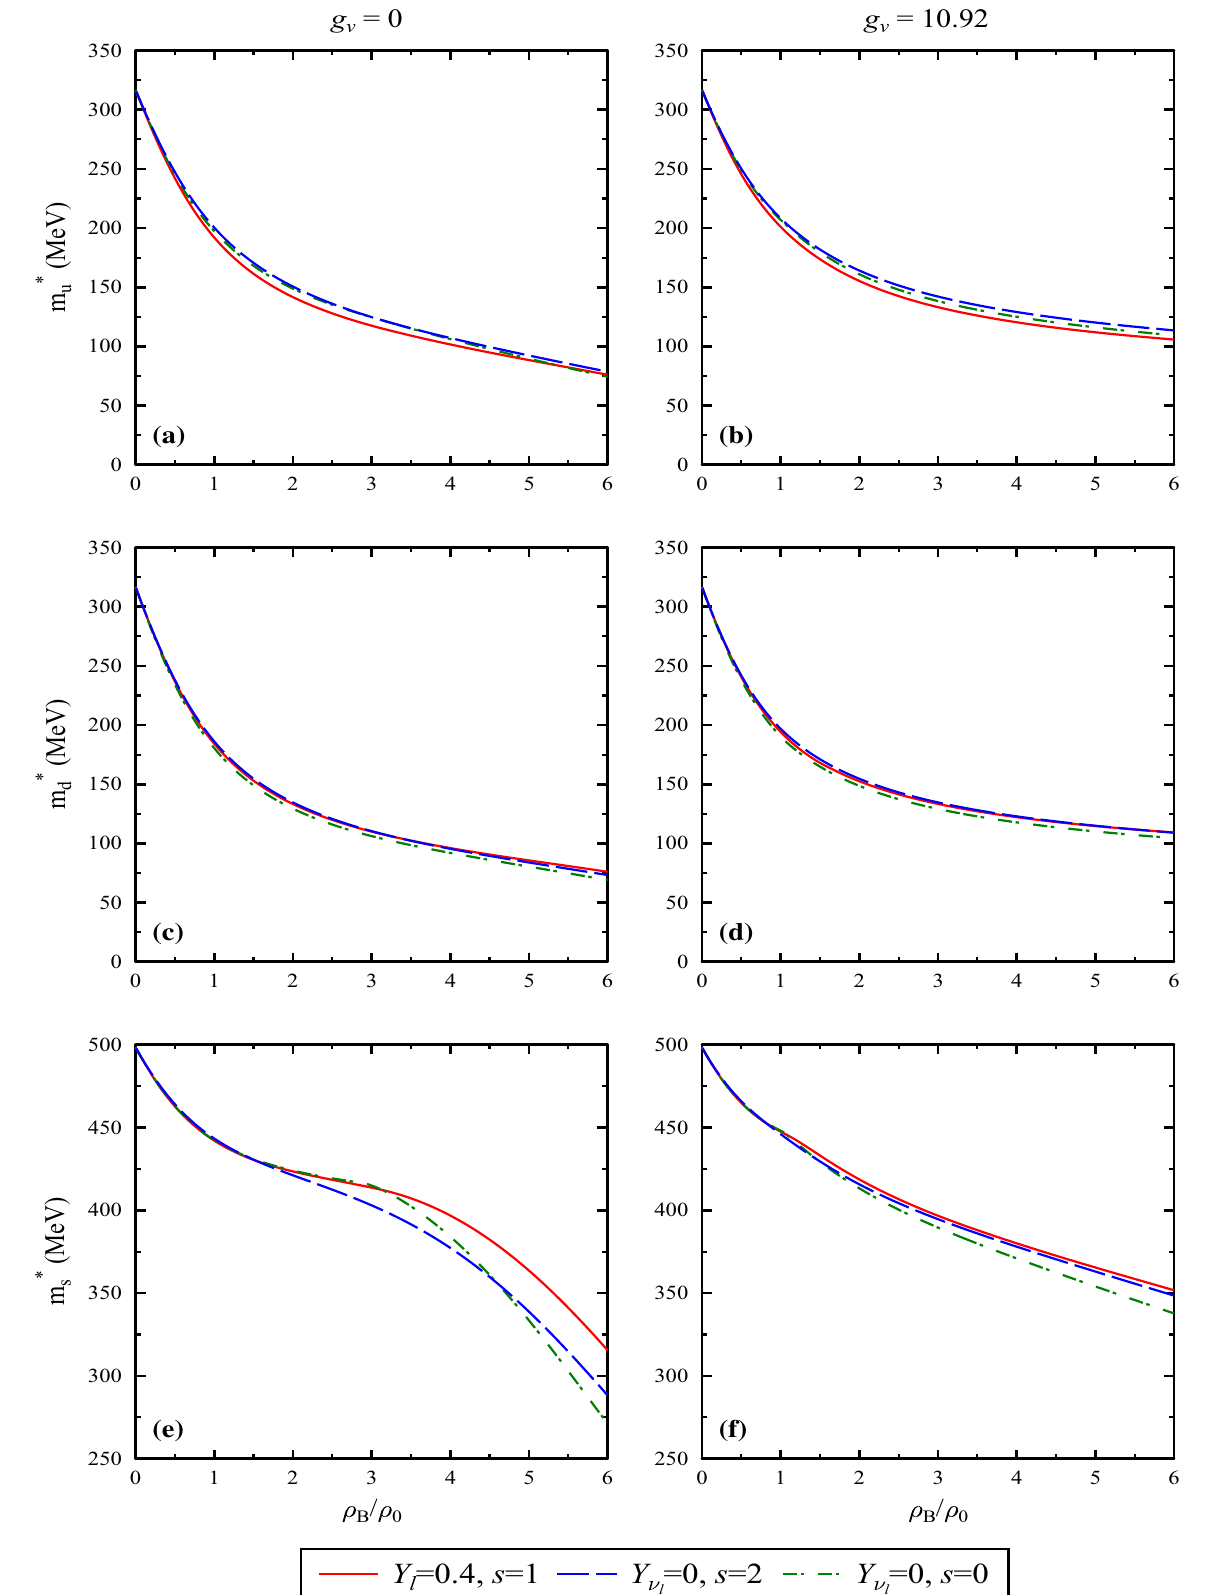
Fig. 2 The effective constituent quark masses, m ∗ (in units of nuclear saturation density ρ 0